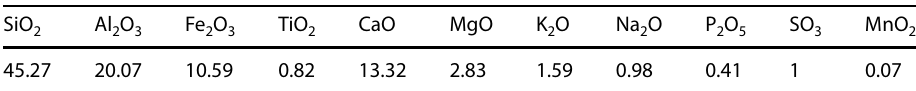
Table 1 Chemical composition of fly ash